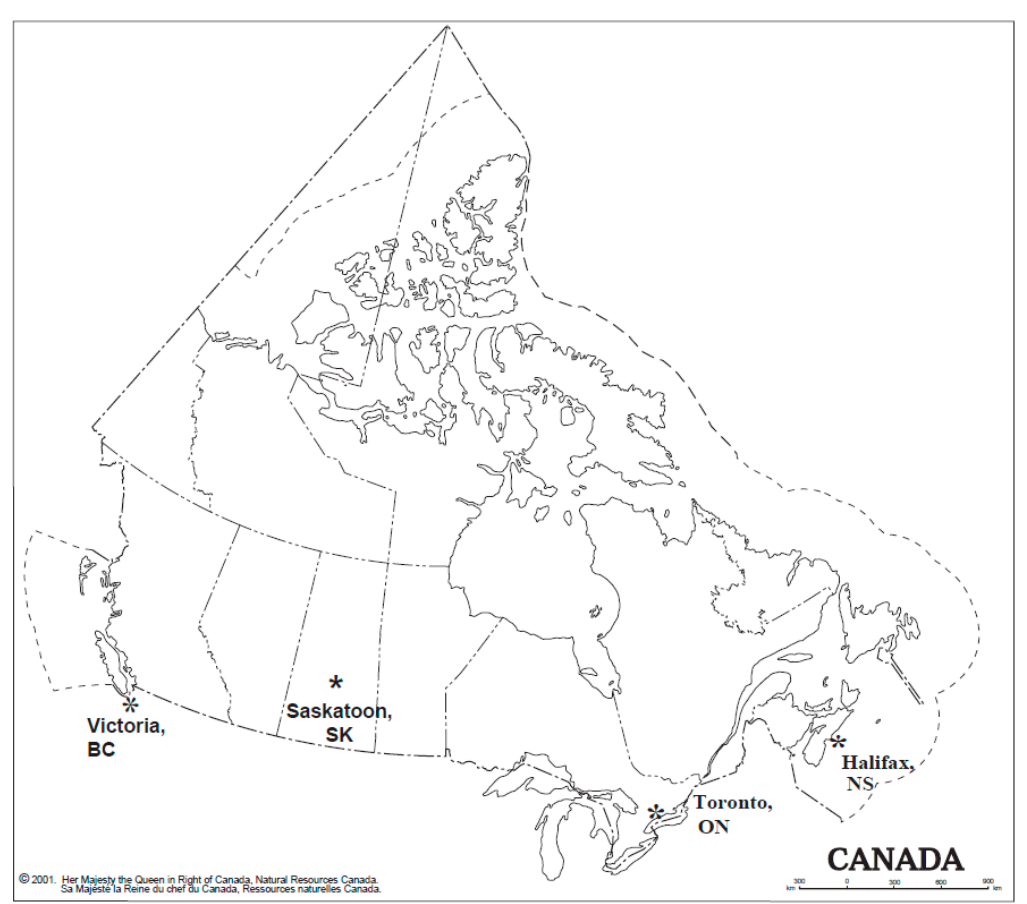
Figure 1. Metropolitan case study areas (Victoria, Saskatoon, Toronto and Halifax, Canada).